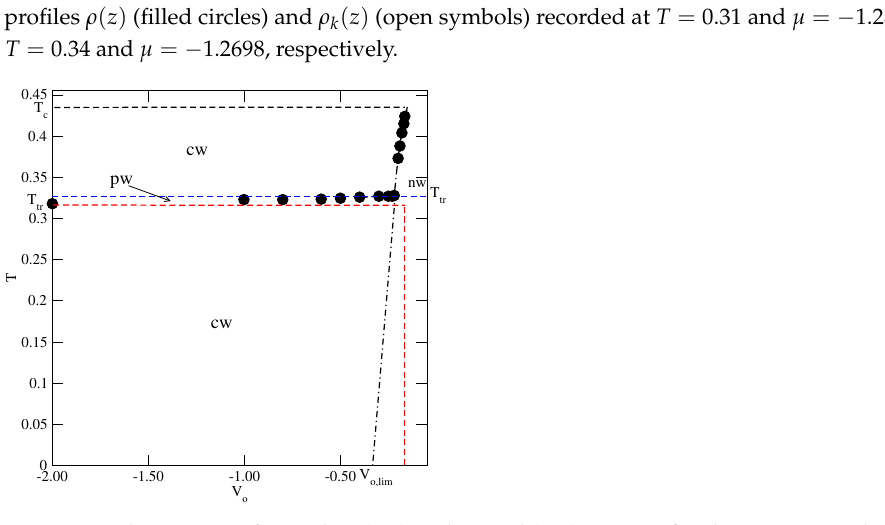
Figure 15. The regions of complete (cw) and partial (pw) wetting for the systems with u ∗ = − 0.2. The horizontal dashed lines mark T tr ( u ∗ = − 0.2 ) , T o ( u ∗ = − 0.2 ) and T ( u ∗ = − 0.2 ) of the bulk system. The vertical dashed line marks the value of V o which delimits the regions of the non-wetting and complete wetting in the ground state. The dash-dotted line marks the expected locations of the wetting temperature in isotropic systems with ¯ u = −